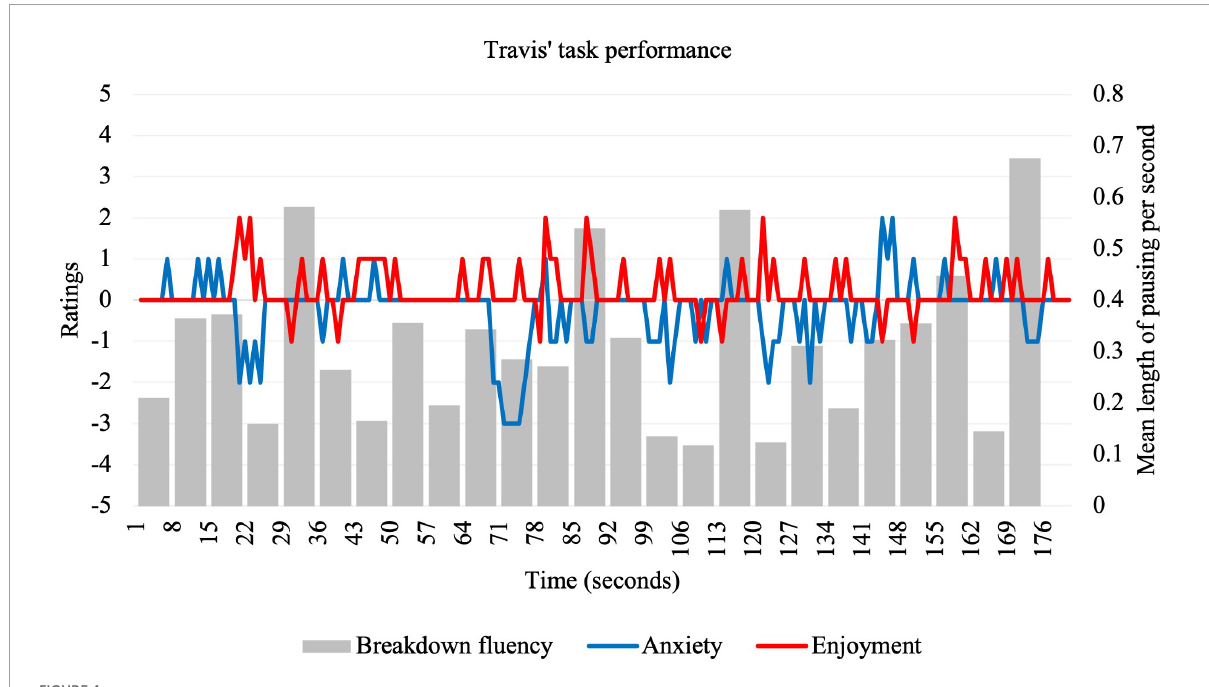
FIGURE4 Idiodynamic ratings and breakdown fluency per segment for Travis’s task performance.